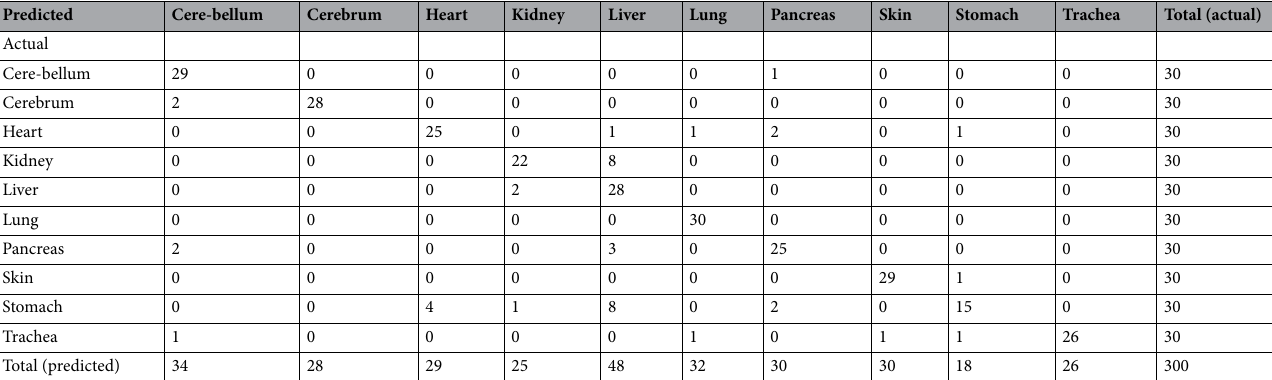
Table 3. Confusion matrix or actual and predicted labels (VML model on validation set, n =